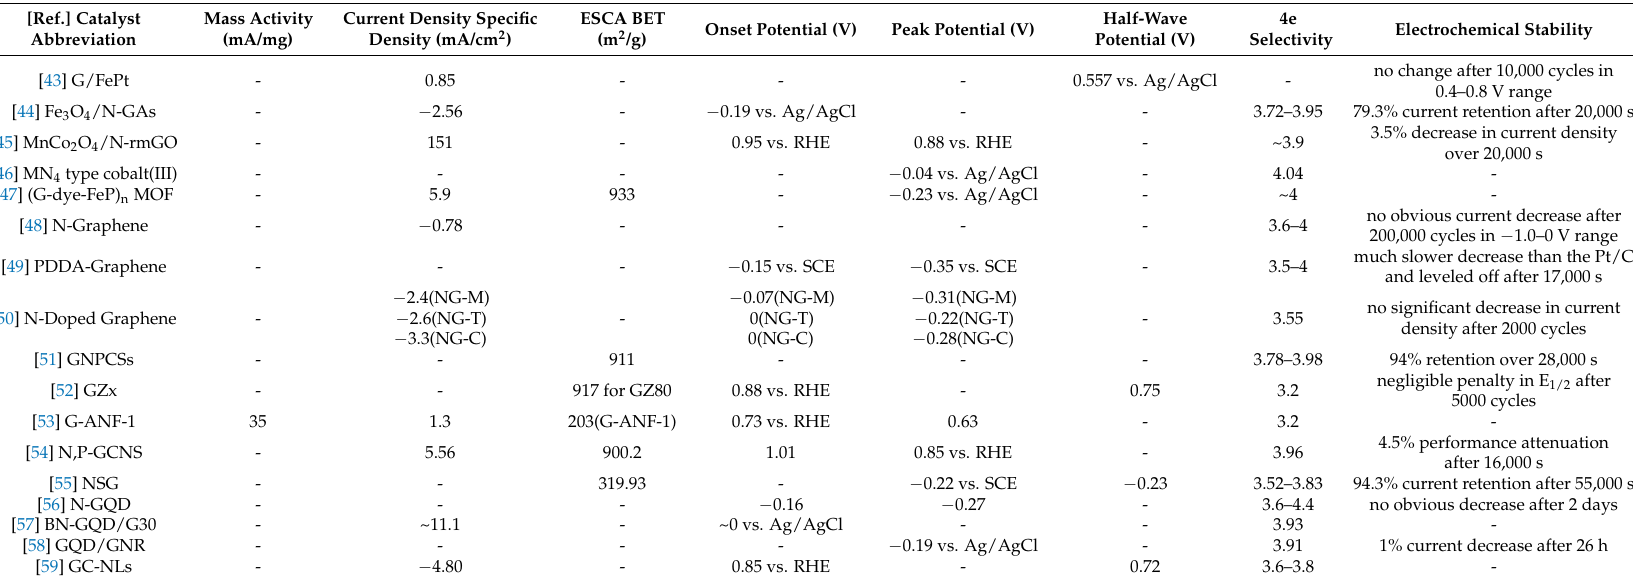
Table 1. Electrocatalysts that are reviewed and their electrochemical